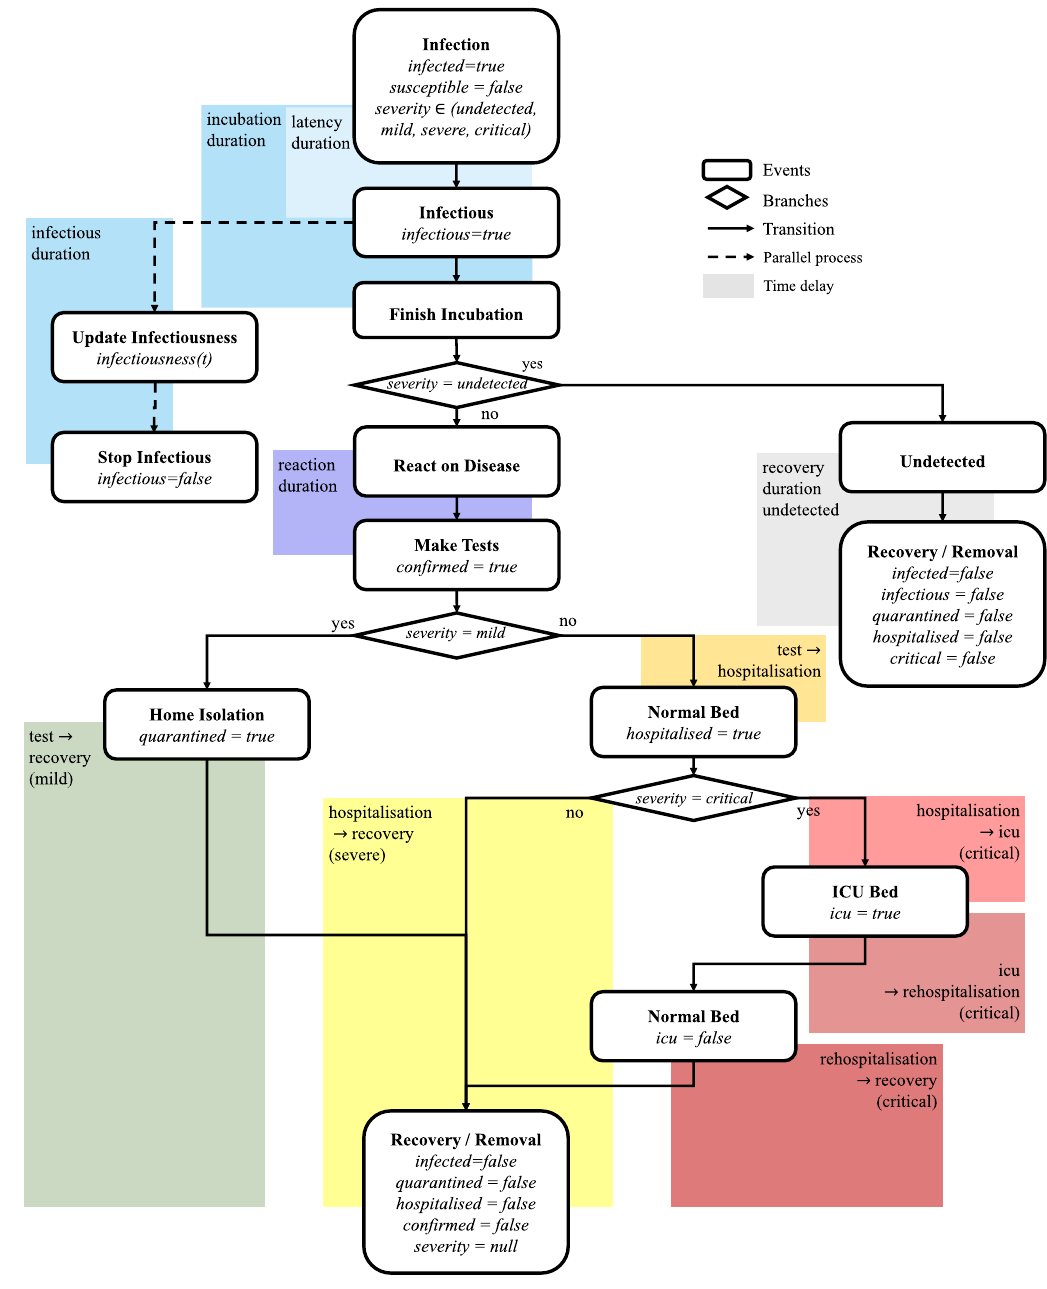
Figure 1. Disease path of an infected agent in the agent-based COVID-19 model. This chart shows an updated version of the one published in the supplemental material of 2